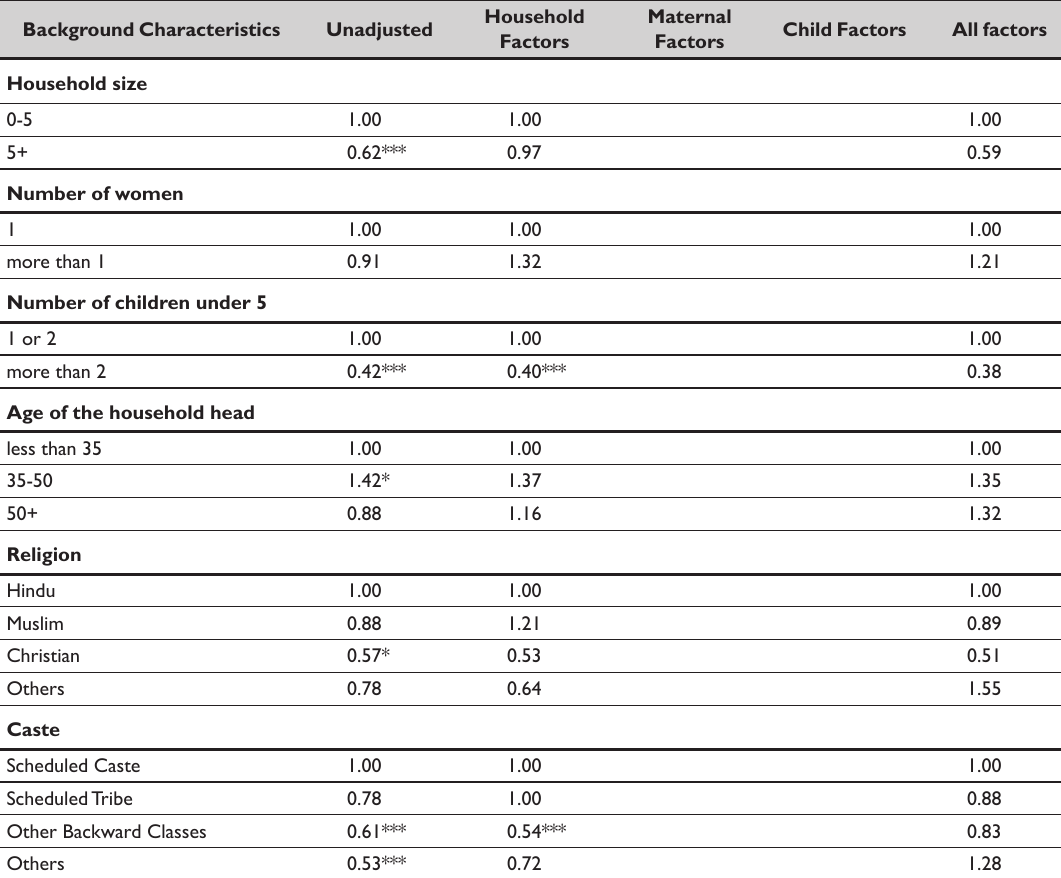
Table 3. Cox proportional hazard model showing odds ratio for infant death from Female Headed households, NFHS-3 (2005-06),